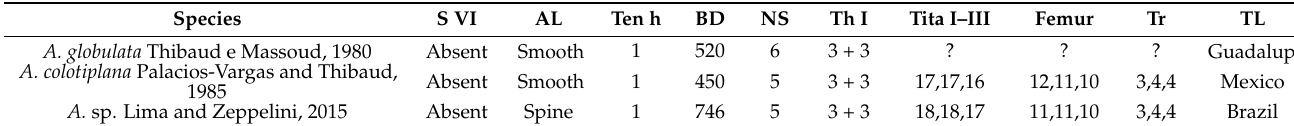
Table 6. Morphological characters of Acherontiella Absolon, 1913 species recorded from Brazil. S VI—spine on Abd VI; AL—anterior labral chaetae; Ten h—tenent hair; BD—body length in µ m; NS—sensilla number of Ant IV; Tr—trochanter;